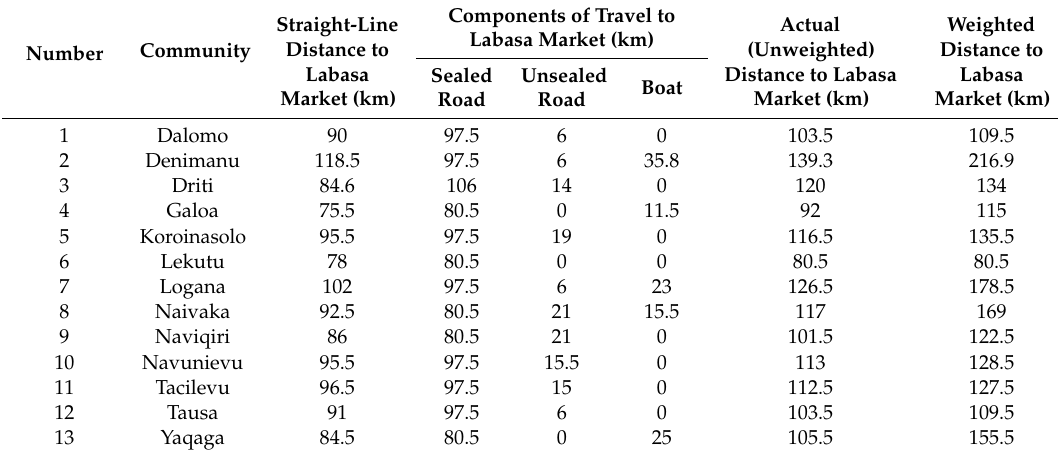
Table 1. Distances along core–periphery gradients for Bua communities as a measure of expected